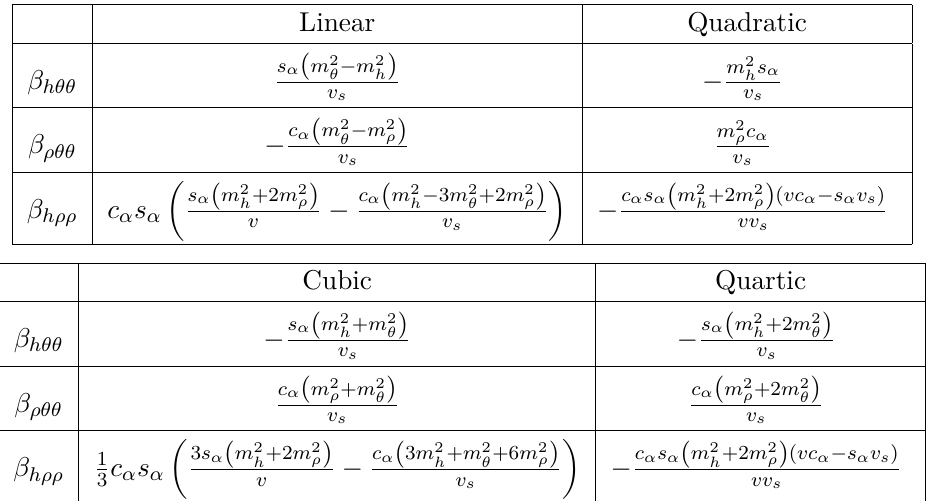
and s . s , m h , m θ , m ρ α